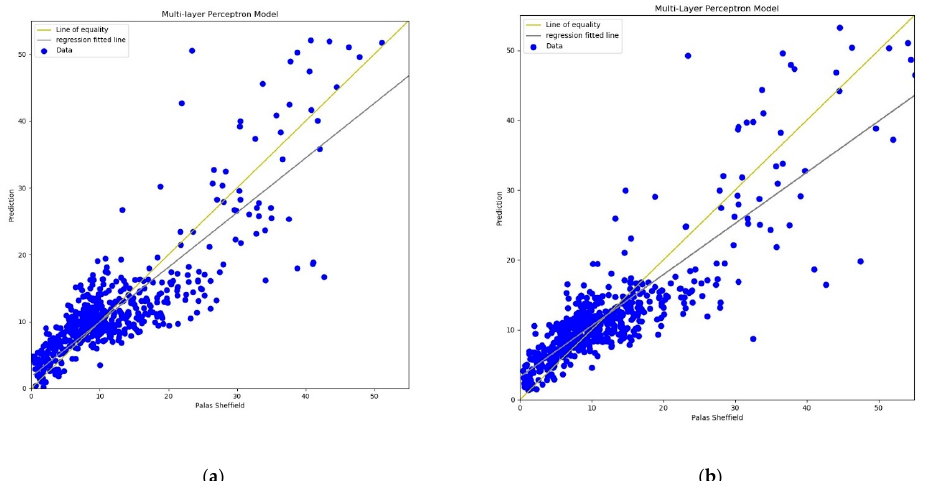
Figure 12. ( a ) MLP calibration scatter plot for PM 10 with the line of equality, regression fitted line, and the calibrated data using AH ; ( b ) MLP calibration scatter plot for PM 10 with the line of equality, regression fitted line, and the calibrated data using RH .